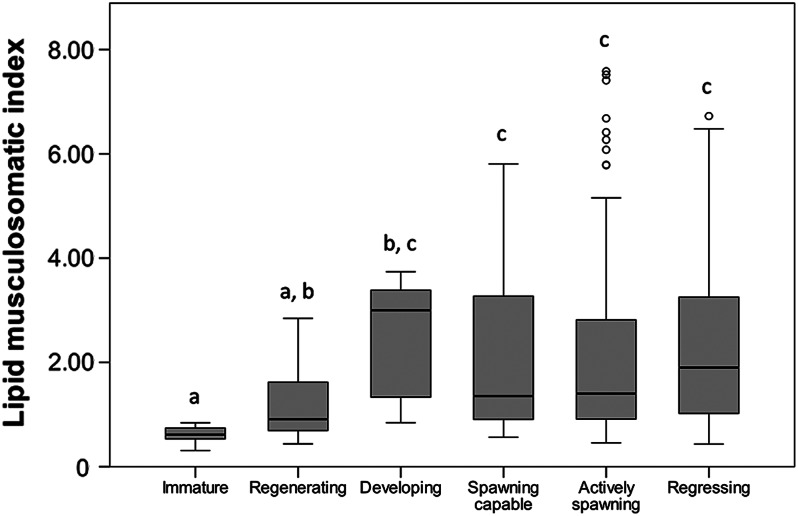
Box-and-whisker plots of lipid musculosomatic index (ILM) in relationship to the different ovarian developmental phases of anchovies. Significant differences among groups (Kruskal–Wallis test, P < 0.05) are indicated with different letters.